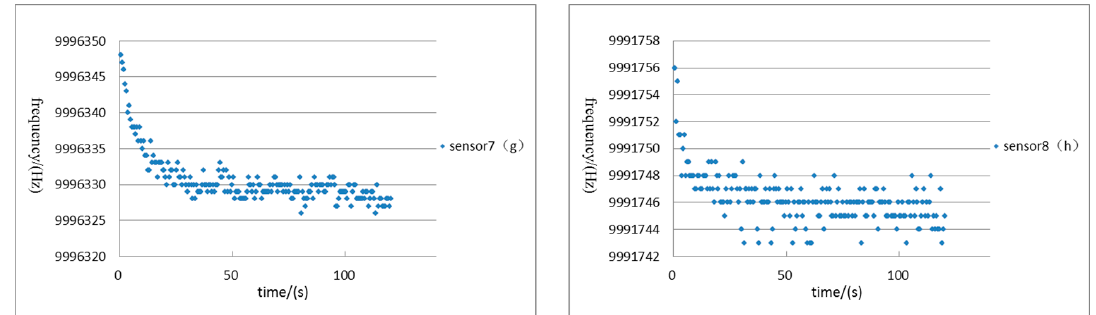
Figure 7. The resonant frequency values with the time extension of sensor 1–8.